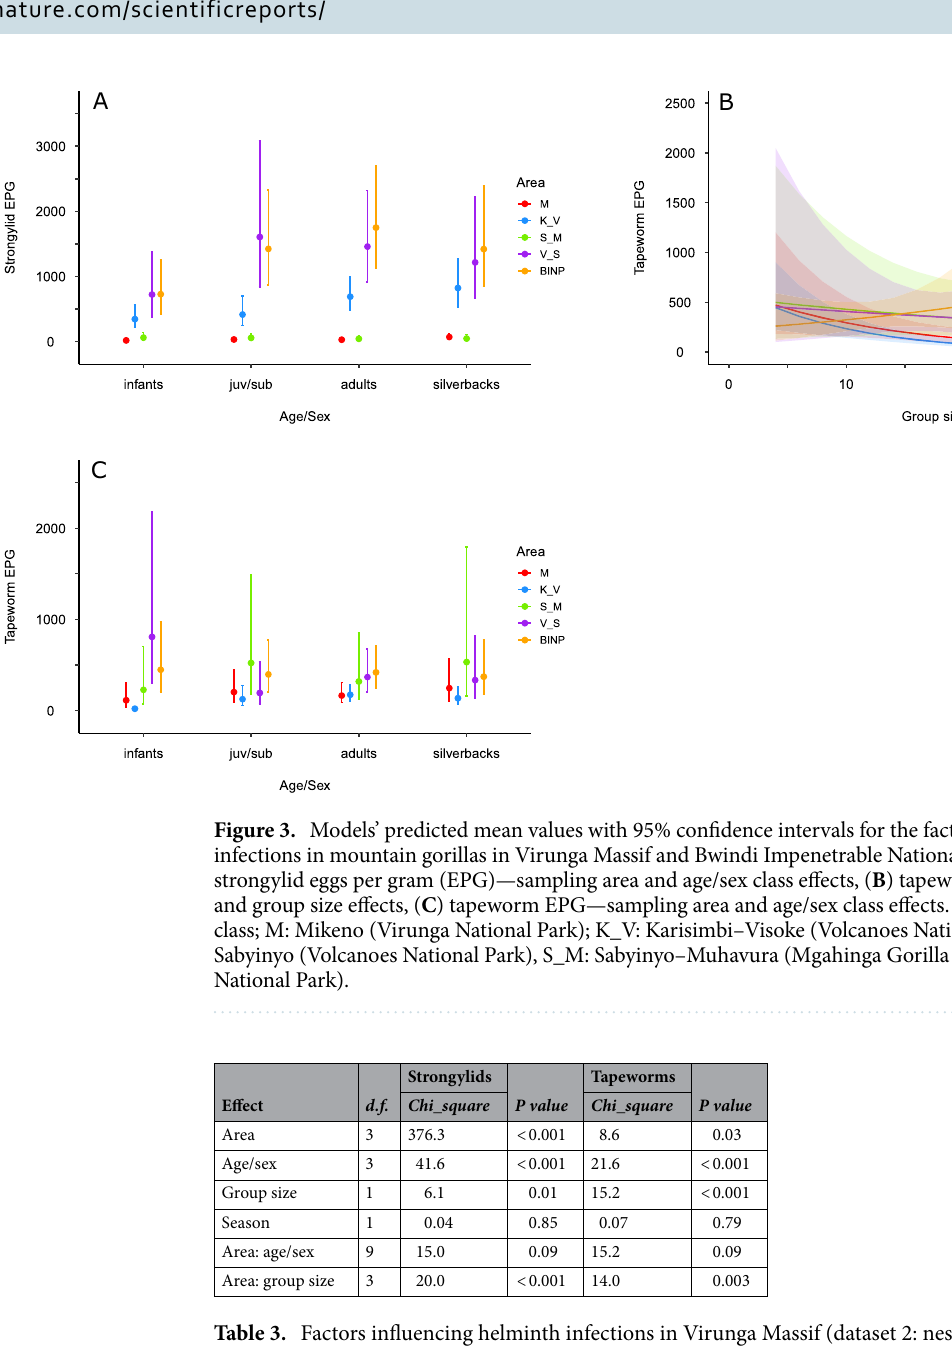
Table 3. Factors influencing helminth infections in Virunga Massif (dataset 2: nest samples from Volcanos and Virunga National Parks from wet and dry season).